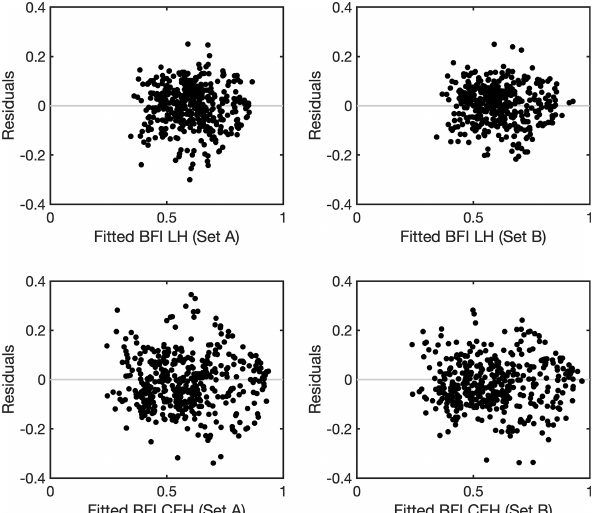
Figure A1. Distribution of residuals for LR models (Models 1 to